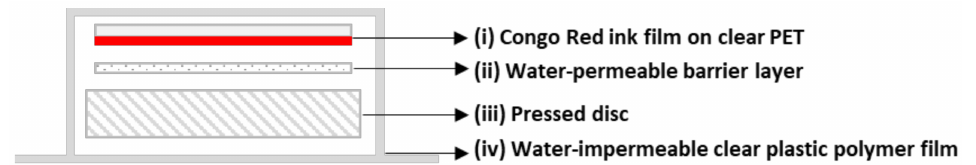
Figure 1. Schematic of the layered HPP indicator, comprising a bright red colour Congo Red